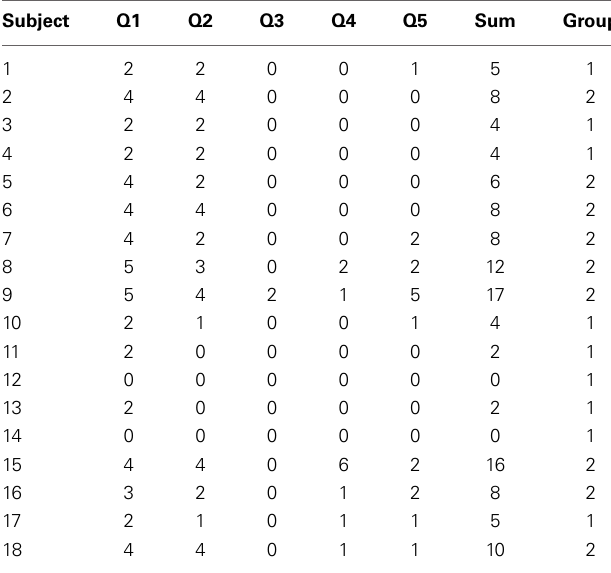
Table 2 | Art familiarity